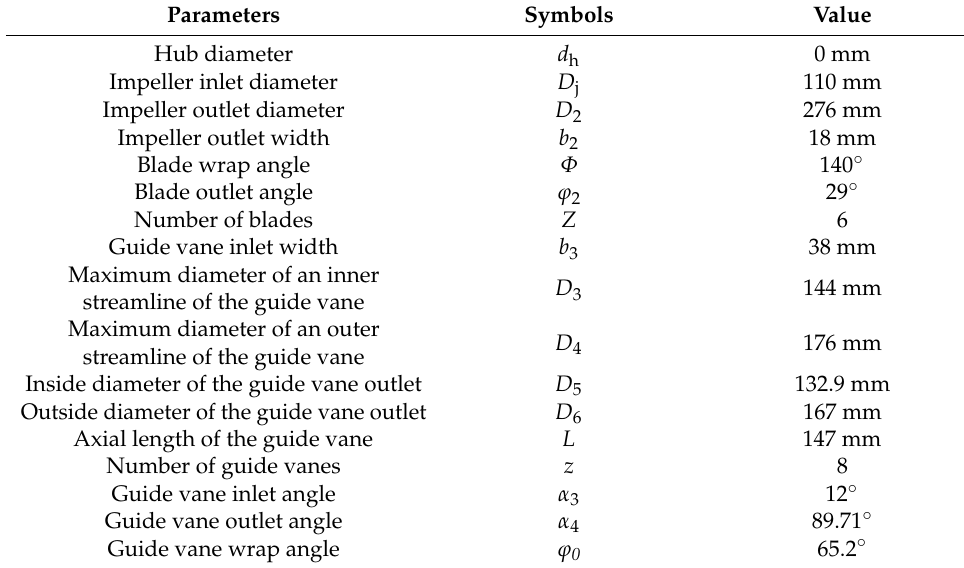
Table 3. The geometric parameters of the redesigned